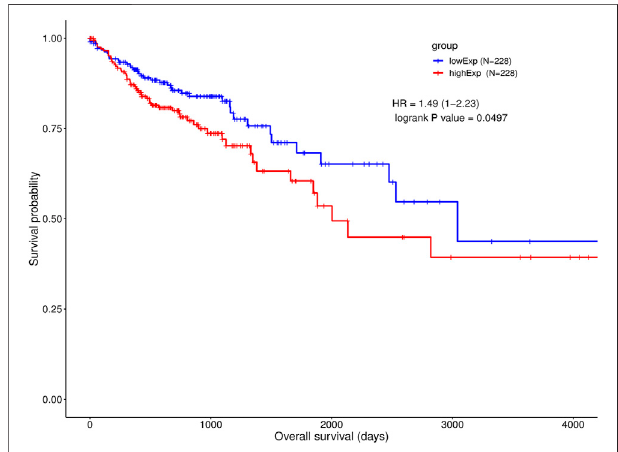
FIGURE 4 | Survival analysis of KCNQ1OT1 ceRNA network and gene co-expressions.Kaplan-MeierandROCcurvesofCRCcohortinhighandlow KCNQ1OT1 expression